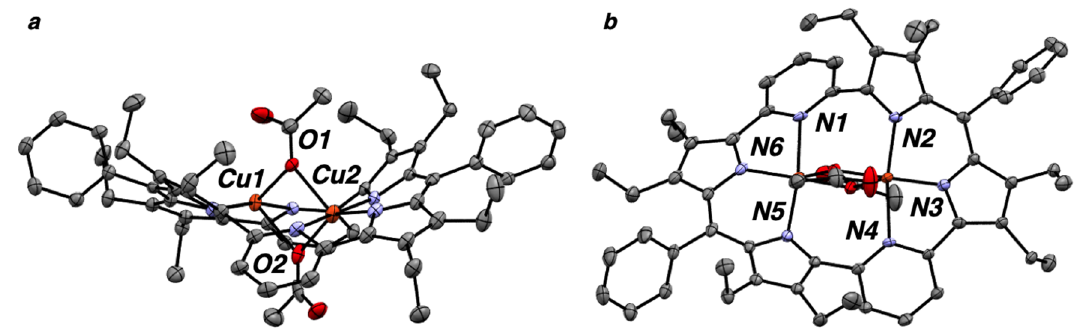
Figure 3. Single crystal X-ray structures of complex 2 viewed from ( a ) side and ( b ) top perspective. Hydrogen atoms are omitted for clarity.